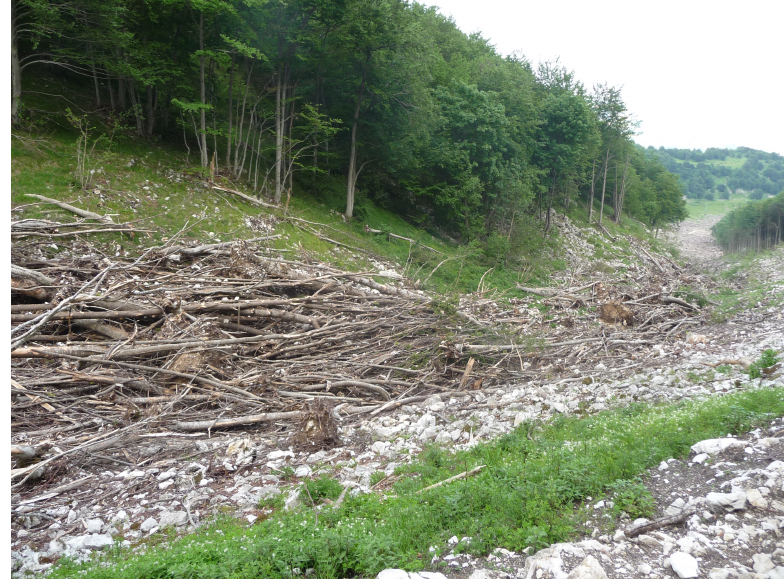
Figure 6. Amassed tree debris in the center of the path. Photo taken at approximately 1350m a.s.l. The Rigopiano area is visible in the